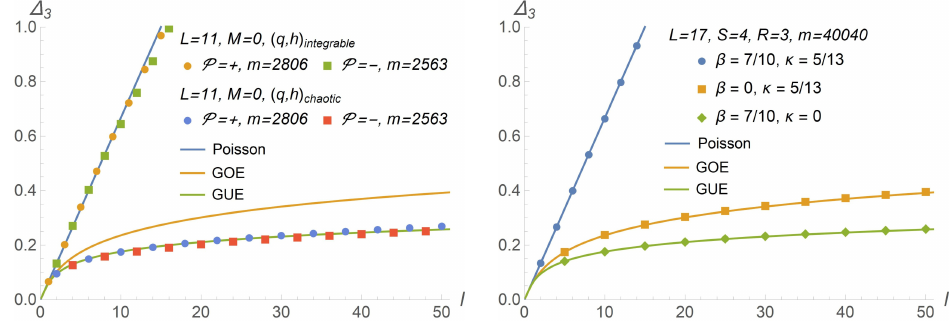
Figure 6 . Left: Dyson-Mehta statistic for ( L = 11 , M = 0) spectra at an integrable and a chaotic point. Right: Dyson-Mehta statistic for ( L = 17 , R = 4 , S = 3) and different configurations of β and κ (with h = 0